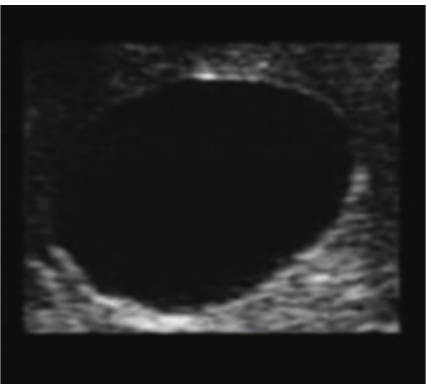
Figure 1: Ultrasound image of axillary